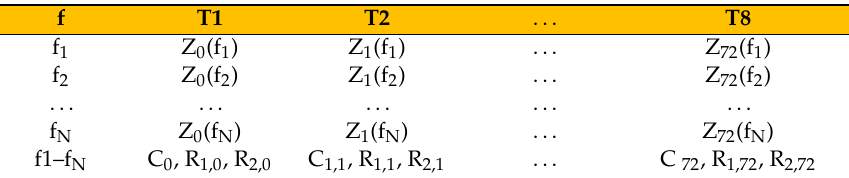
Table 4. Electric Equivalent Circuit for each range of frequencies.